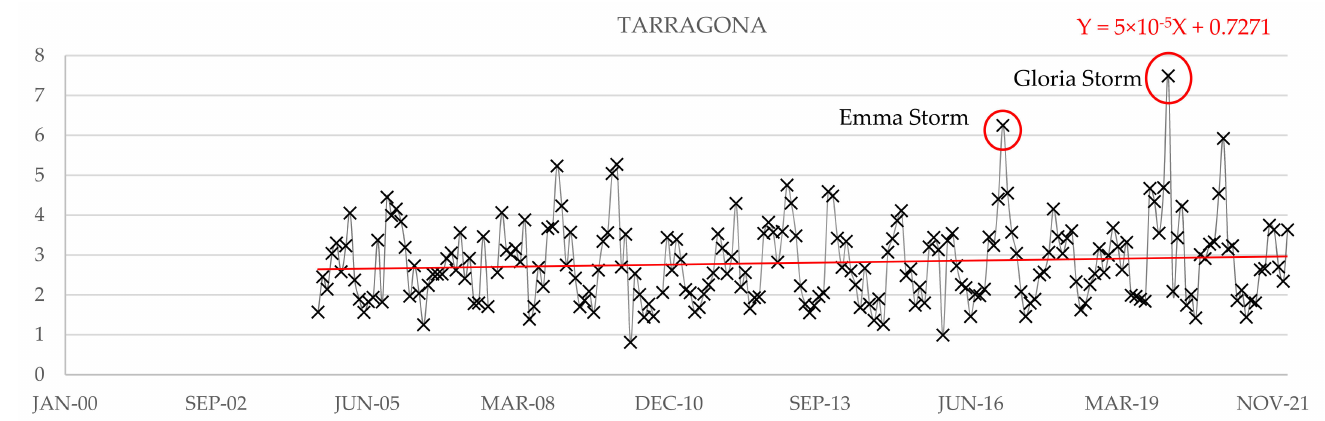
Figure 8. Evolution of Hs maxima in Mahon.